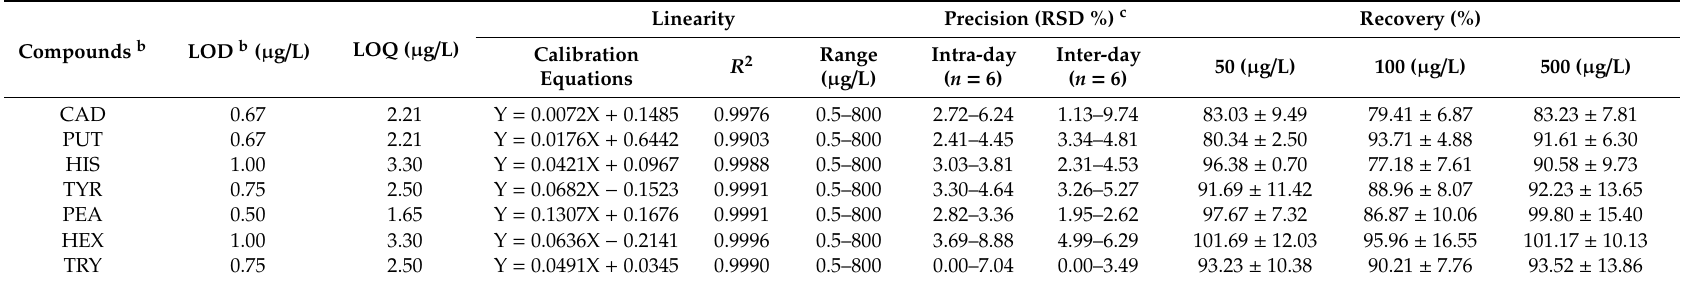
Table 2. LODs, LOQs, linearity, precision and recovery of seven BAs a